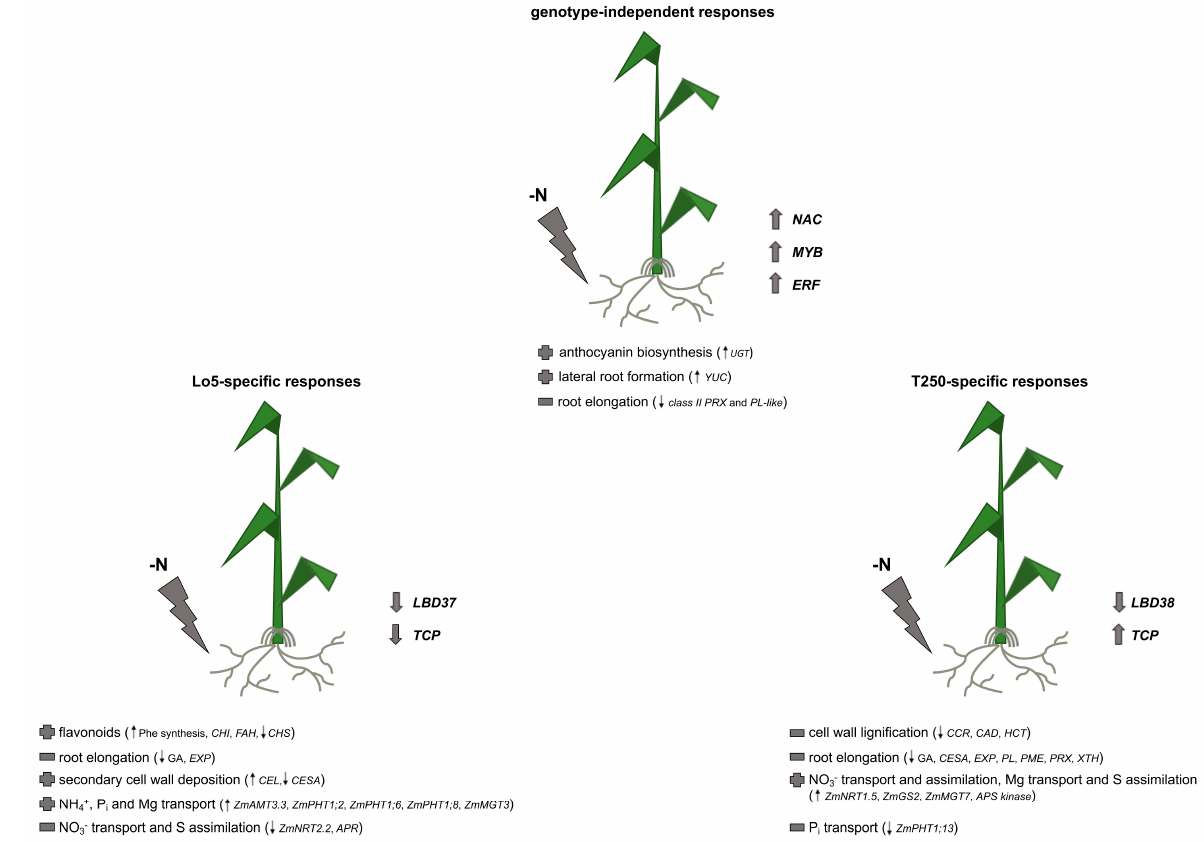
Figure 6. Schematic representation of genotype-independent and Lo5- and T250-specific root responses